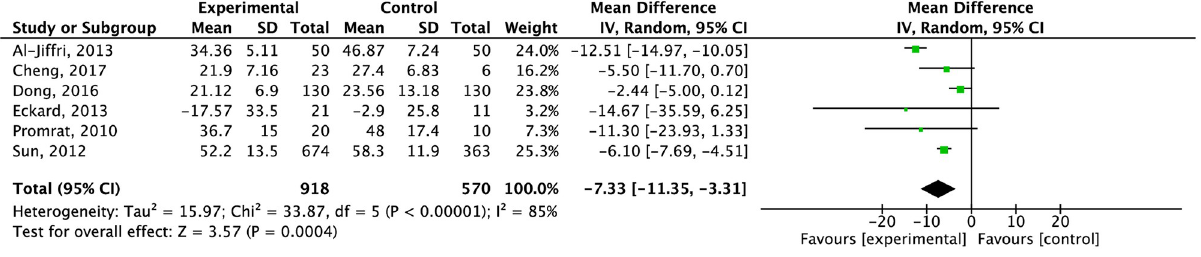
PLOS ONE | https://doi.org/10.1371/journal.pone.0263931 February 17,